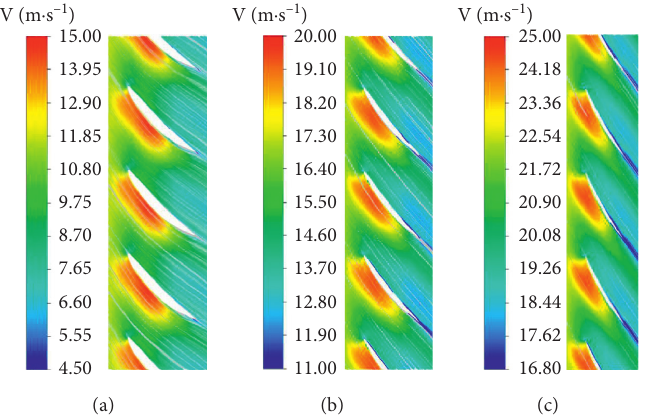
Figure 13: The velocity streamline of each span in Scheme III ( Q � Q